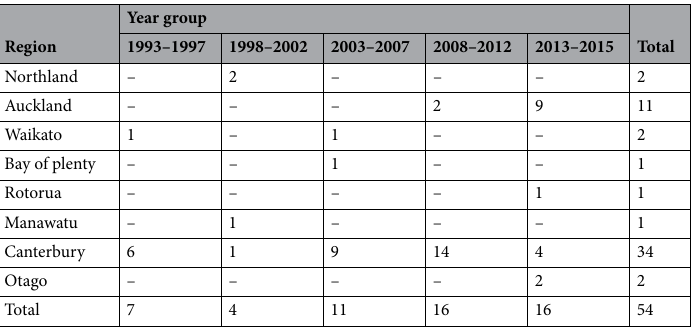
Table 1. Number of isolates sequenced and analysed by year group and